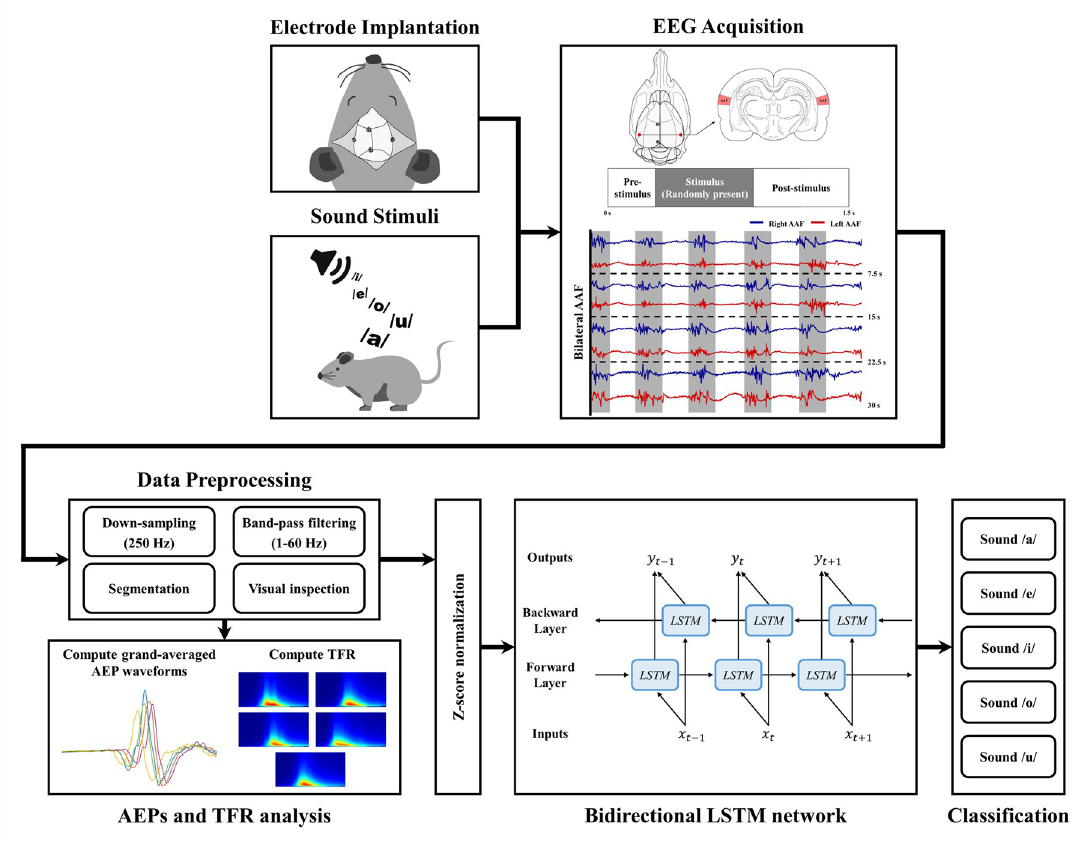
Fig 2. Schematic description of the experimental